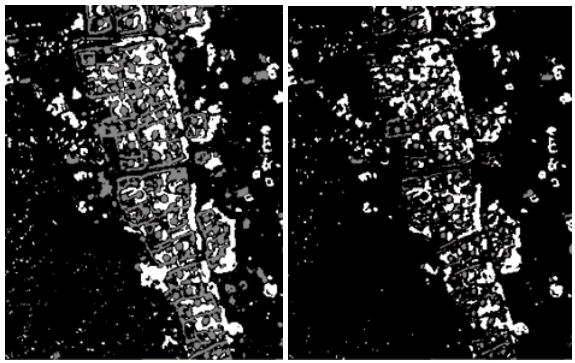
Fig. 5 Change detection by image difference (left) and image ratio (right) PCA